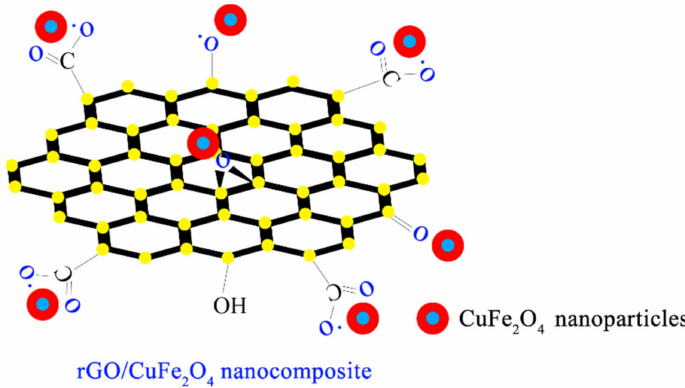
Figure 3. Chemical structural formula of CuFe 2 O 4- rGO [60].